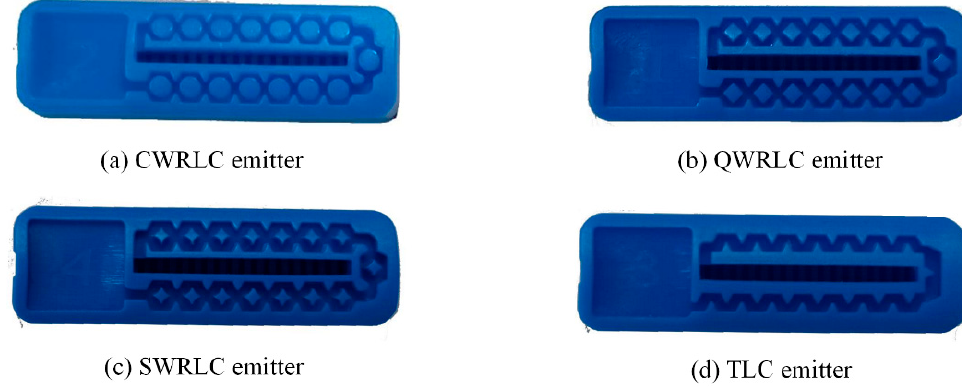
Figure 12. Four real emitters.